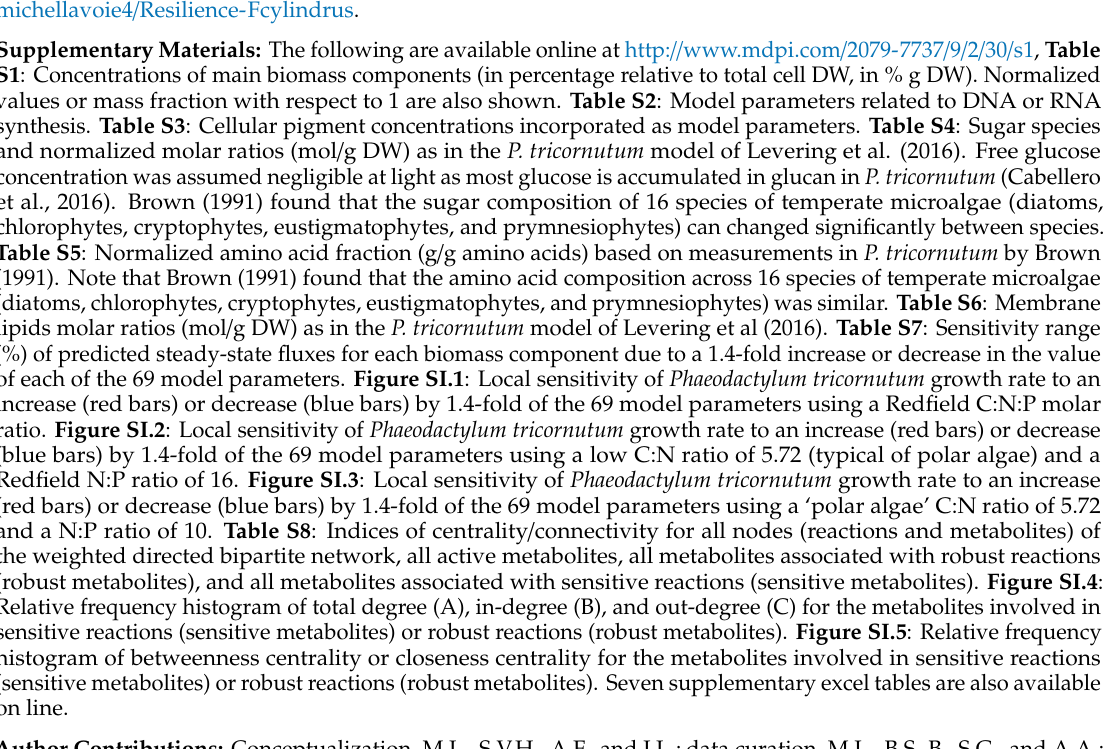
synthesis. Table S3 : Cellular pigment concentrations incorporated as model parameters. Table S4 : Sugar species and normalized molar ratios (mol / g DW) as in the P. tricornutum model of Levering et al. (2016). Free glucose concentration was assumed negligible at light as most glucose is accumulated in glucan in P. tricornutum (Cabellero et al., 2016). Brown (1991) found that the sugar composition of 16 species of temperate microalgae (diatoms, chlorophytes, cryptophytes, eustigmatophytes, and prymnesiophytes) can changed significantly between species. Table S5 : Normalized amino acid fraction (g / g amino acids) based on measurements in P. tricornutum by Brown (1991). Note that Brown (1991) found that the amino acid composition across 16 species of temperate microalgae (diatoms, chlorophytes, cryptophytes, eustigmatophytes, and prymnesiophytes) was similar. Table S6 : Membrane lipids molar ratios (mol / g DW) as in the P. tricornutum model of Levering et al (2016). Table S7 : Sensitivity range (%) of predicted steady-state fluxes for each biomass component due to a 1.4-fold increase or decrease in the value of each of the 69 model parameters. Figure SI.1 : Local sensitivity of Phaeodactylum tricornutum growth rate to an increase (red bars) or decrease (blue bars) by 1.4-fold of the 69 model parameters using a Redfield C:N:P molar ratio. Figure SI.2 : Local sensitivity of Phaeodactylum tricornutum growth rate to an increase (red bars) or decrease (blue bars) by 1.4-fold of the 69 model parameters using a low C:N ratio of 5.72 (typical of polar algae) and a Redfield N:P ratio of 16. Figure SI.3 : Local sensitivity of Phaeodactylum tricornutum growth rate to an increase (red bars) or decrease (blue bars) by 1.4-fold of the 69 model parameters using a ‘polar algae’ C:N ratio of 5.72 and a N:P ratio of 10. Table S8 : Indices of centrality / connectivity for all nodes (reactions and metabolites) of the weighted directed bipartite network, all active metabolites, all metabolites associated with robust reactions (robust metabolites), and all metabolites associated with sensitive reactions (sensitive metabolites). Figure SI.4 : Relative frequency histogram of total degree (A), in-degree (B), and out-degree (C) for the metabolites involved in sensitive reactions (sensitive metabolites) or robust reactions (robust metabolites). Figure SI.5 : Relative frequency histogram of betweenness centrality or closeness centrality for the metabolites involved in sensitive reactions (sensitive metabolites) or robust reactions (robust metabolites). Seven supplementary excel tables are also available on